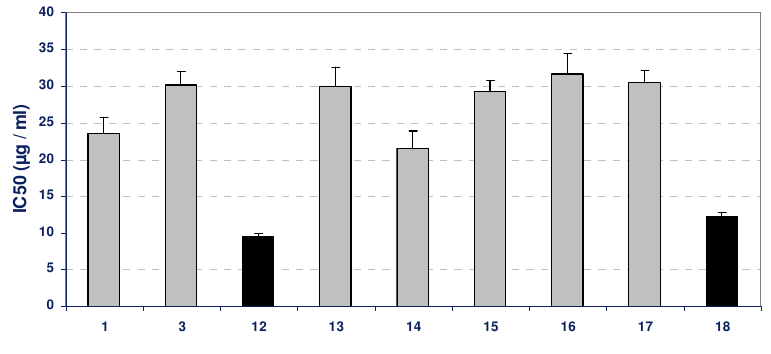
Figure 1. Cytotoxicity (IC , µg/mL) of different tested compounds against human 50 Hep-G2 cells 48 hours of incubation. The grey bars represent non-cytotoxic compounds, and the black bars represent the promising cytotoxic compounds. Data represent mean value of IC ± 50